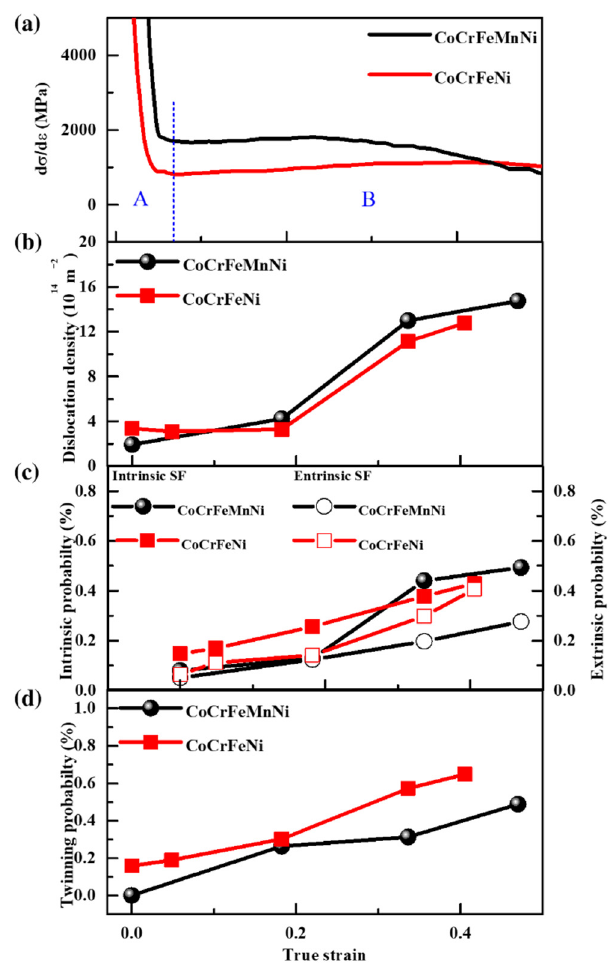
Figure 3. ( a ) Work ‐ hardening rate, ( b ) dislocation density, ( c ) formation probabilities of intrinsic and extrinsic stacking faults (SFs), and ( d ) formation probability of twins as a function of macroscopic true strain along the axial loading direction in CoCrFeNi and CoCrFeMnNi HEAs. CMWP was employed to quantitatively determine different kinds of structural de ‐ fects governing the dominant behavior at each deformation regime during straining in both quaternary and quinary alloys. The dynamic evolution of dislocation density, stack ‐ ing faults (SF), and twinning analyzed by CMWP fitting procedures was related to the variation in peak shape and peak width broadening of the diffraction profiles. The SF and twinning formation probabilities were directly determined based on the shifts and breadths of the sum of symmetrical and asymmetrical Lorentzian ‐ function ‐ based sub ‐ pro ‐ files, given by fifth ‐ order polynomials of the planar fault density [32,33]. The type of sub ‐ profiles follows the specific selection rule for the hkl indices of the Bragg reflections [32]. The dislocation density is related to the Fourier coefficient of the strain profile as follows [8,24,33,34]: (1) where b is the absolute value of the Burgers vector, g is the absolute value of the diffraction vector, C is the dislocation contrast factor, ρ is the dislocation density, L is the variable of the Fourier transform, f is the Wilkens’ function, and R e * is the cut ‐ off radius of the dislo ‐ cations.